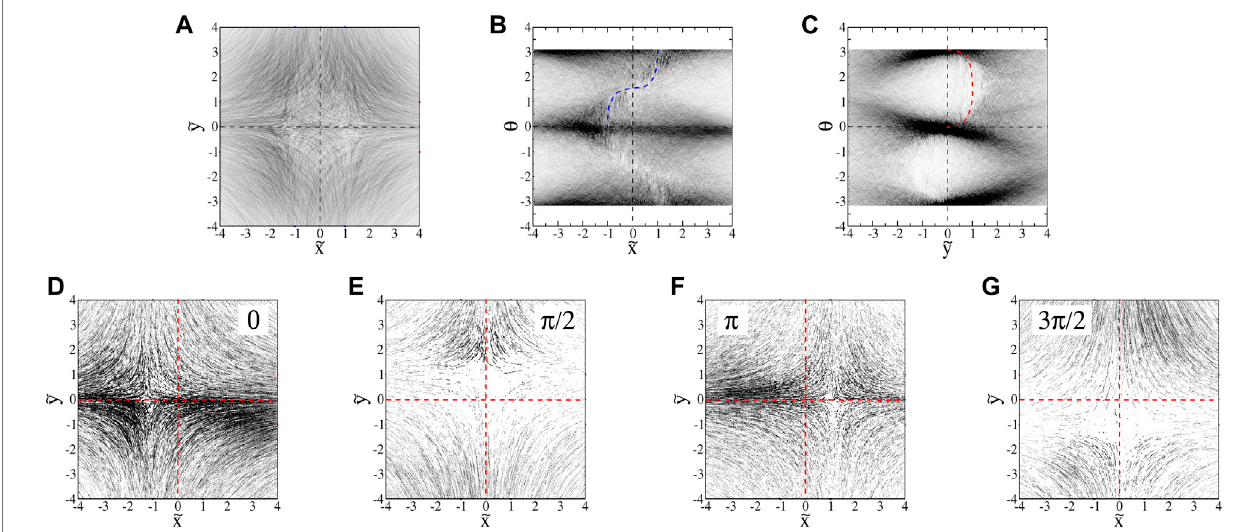
FIGURE 10 | : Projections of euglena histograms (0.200 ml/min fl ow, A = 3.6s − 1 ) into (A) ( ~ x , ~ y ) space, (B) ( ~ x , θ ) space, and (C) ( ~ y , θ ) space. The darker shades correspond to the larger values. The blue and red dashed curves in panels (B,C) correspond to the top half of projections of the SwIMs seen in Figures 3B,C . Slices of euglena histograms (0.200 ml/min fl ow, A = 3.6s − 1 ) for data within 0.1 radian of (D) 0, (E) π /2, (F) π , and (G) 3 π /2 radians. In panels (D – G) , the red dashed lines are the passive manifolds of the fl ow ’ s fi xed